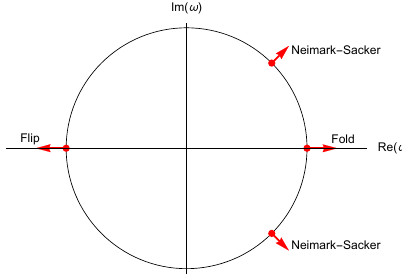
Figure 1. Bifurcations on the stability unit